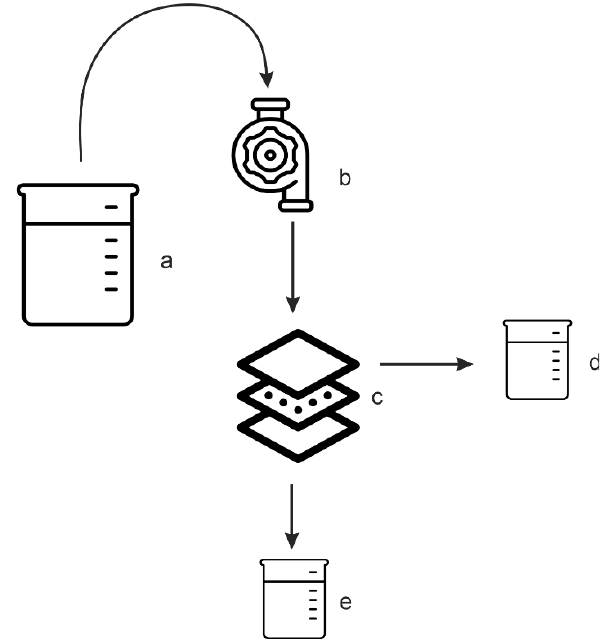
Figure 2. Schematic of the unit for assessing a membrane’s water permeability: ( a )—water intake collector; ( b )—water pump; ( c )—filtration cell; ( d )—retentate collector; ( e )—permeate